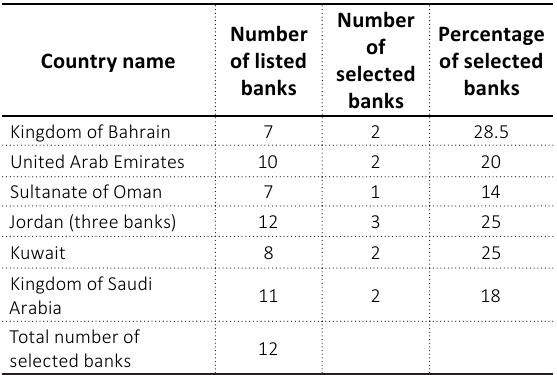
Table 1. Distribution of sample banks selected for the current study